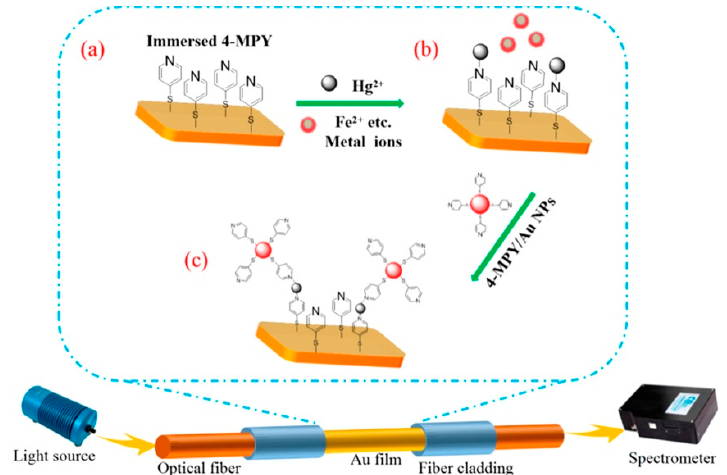
Figure 5. Sensing mechanism of LSPR fiber Hg 2 + sensor. Capture of ( a ) 4-MPY and ( b ) Hg 2 + ; ( c ) Selectively bind of Hg 2 + on Au NPs surface [86].